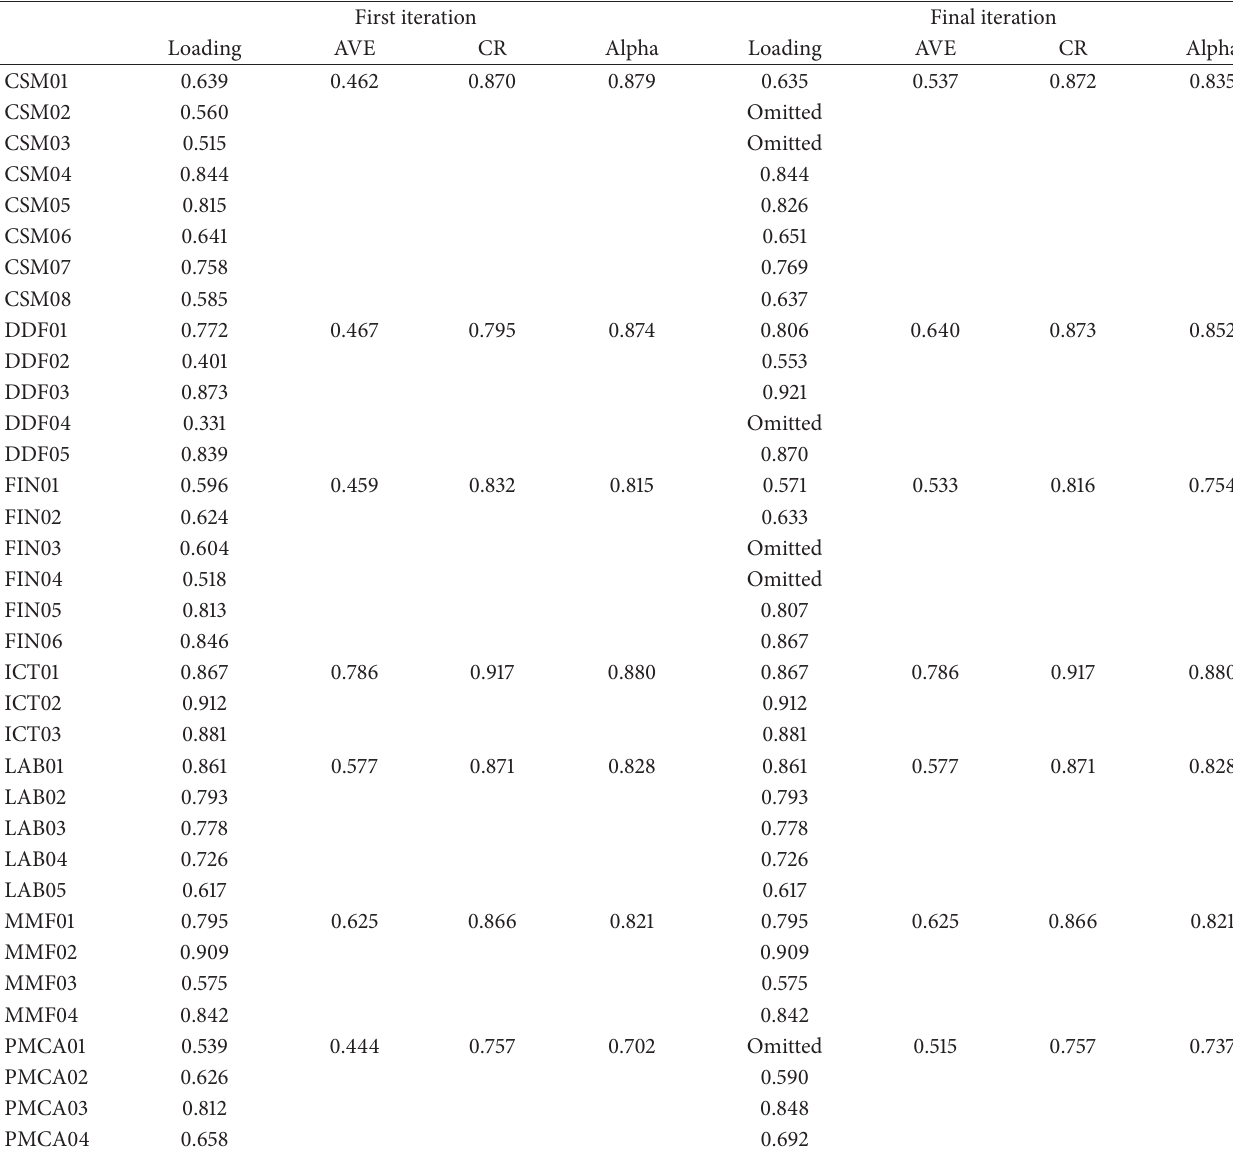
Table 2: Results of measurement model